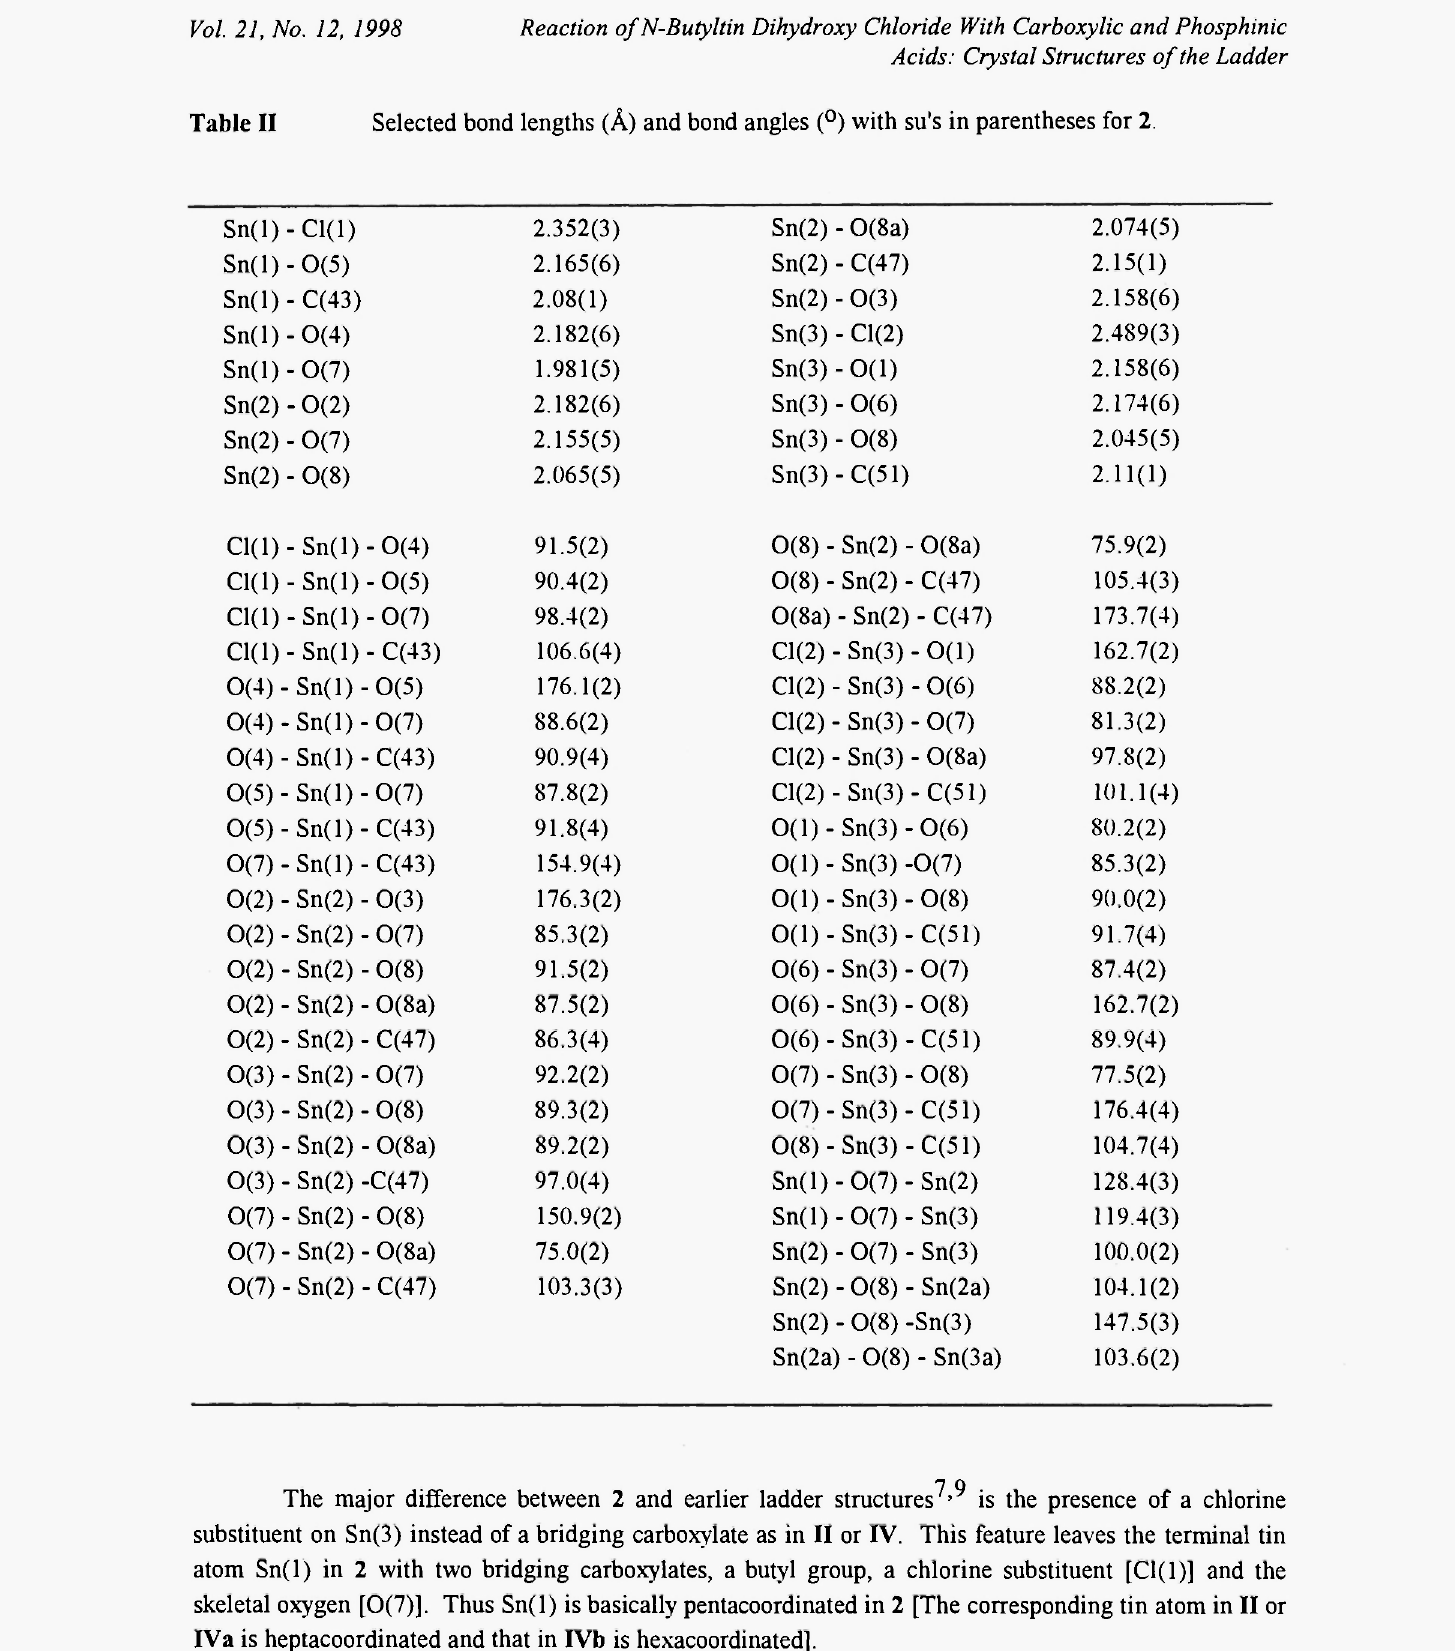
Selected bond lengths (Ä) and bond angles (°) with su's in parentheses for 2.